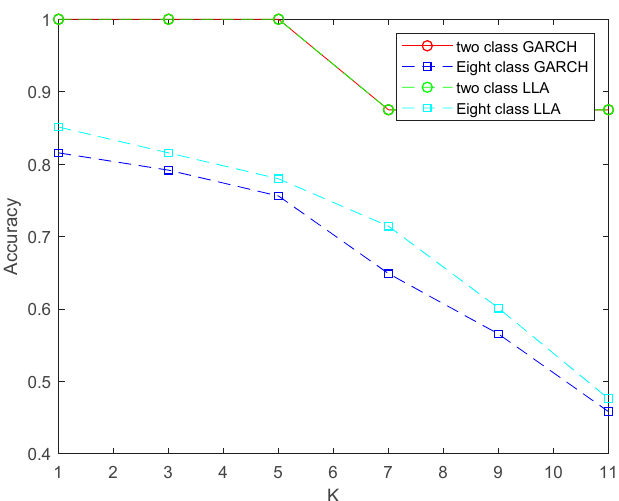
Figure 9. The plots of the accuracy of the two- and eight-class methods for di ff erent K values.